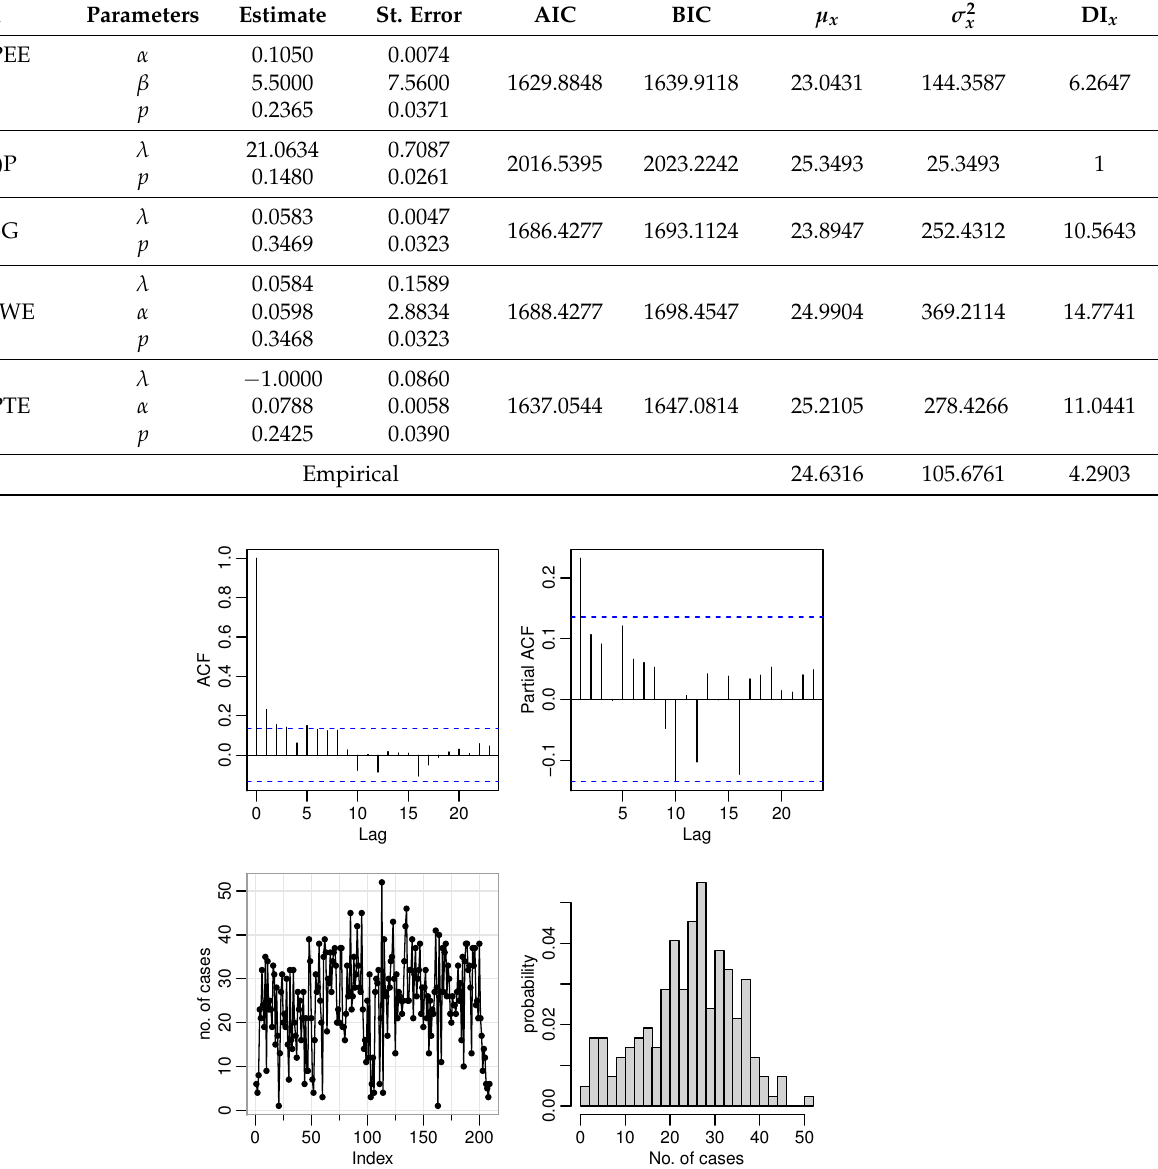
Table 11. Estimates and modelling adequacy statistics for the number of syphilis cases data.